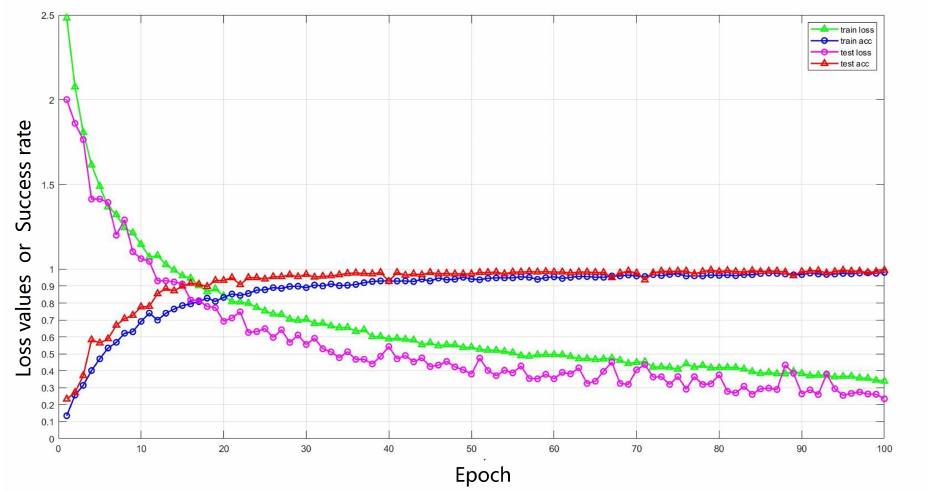
Figure 8. Loss values and success rate of the proposed BN-CNN model.